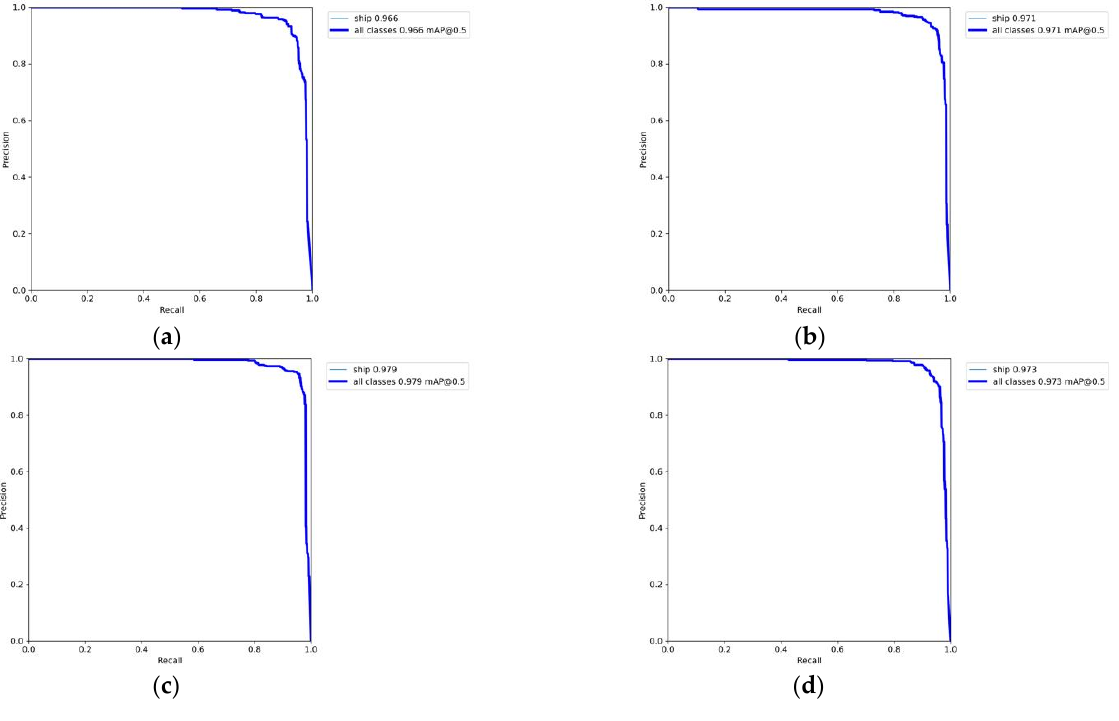
Figure 18. The influence of four different weights set during image fusion on the P–R curve. ( a ) P-R curve of FLNet on SSDD dataset when the image fusion weight is 0.25; ( b ) P-R curve of FLNet on SSDD dataset when the image fusion weight is 0.5; ( c ) P-R curve of FLNet on SSDD dataset when the image fusion weight is 0.75; ( d ) P-R curve of FLNet on SSDD dataset when the image fusion weight is 1. Table 5. Experimental results of FLNet with different fusion weights on the SSDD dataset. Weights Precision